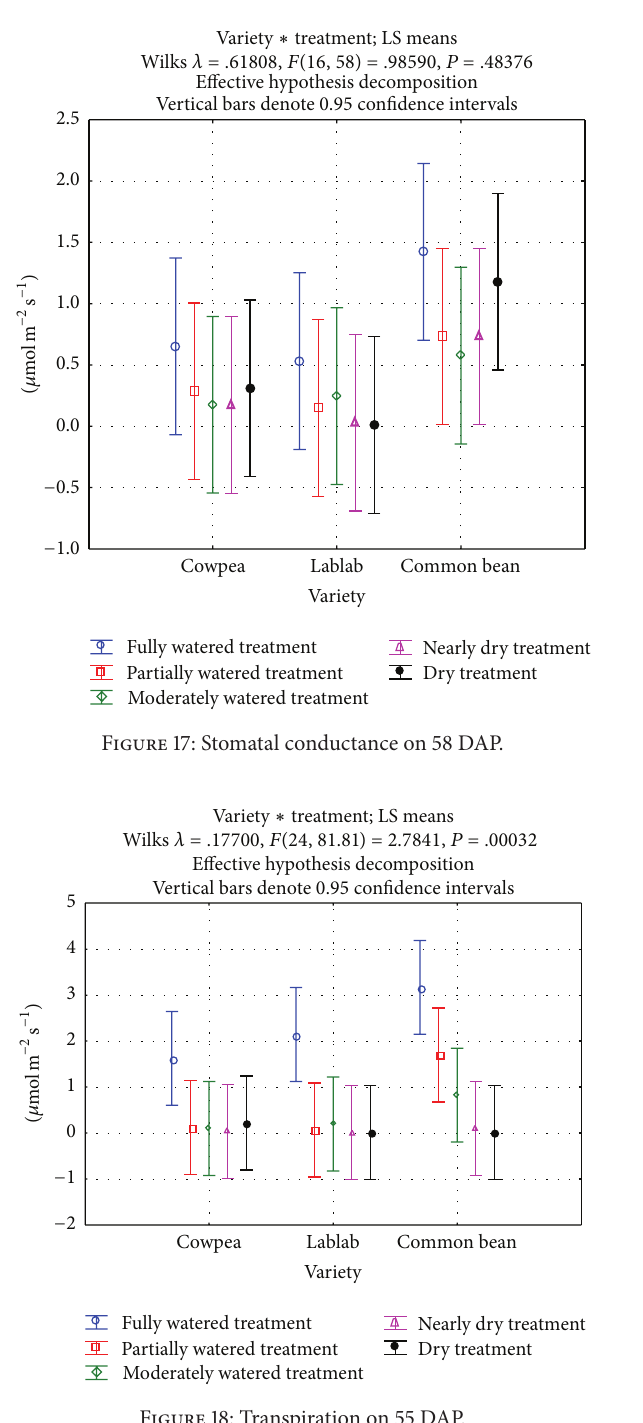
Figure 18: Transpiration on 55 DAP.